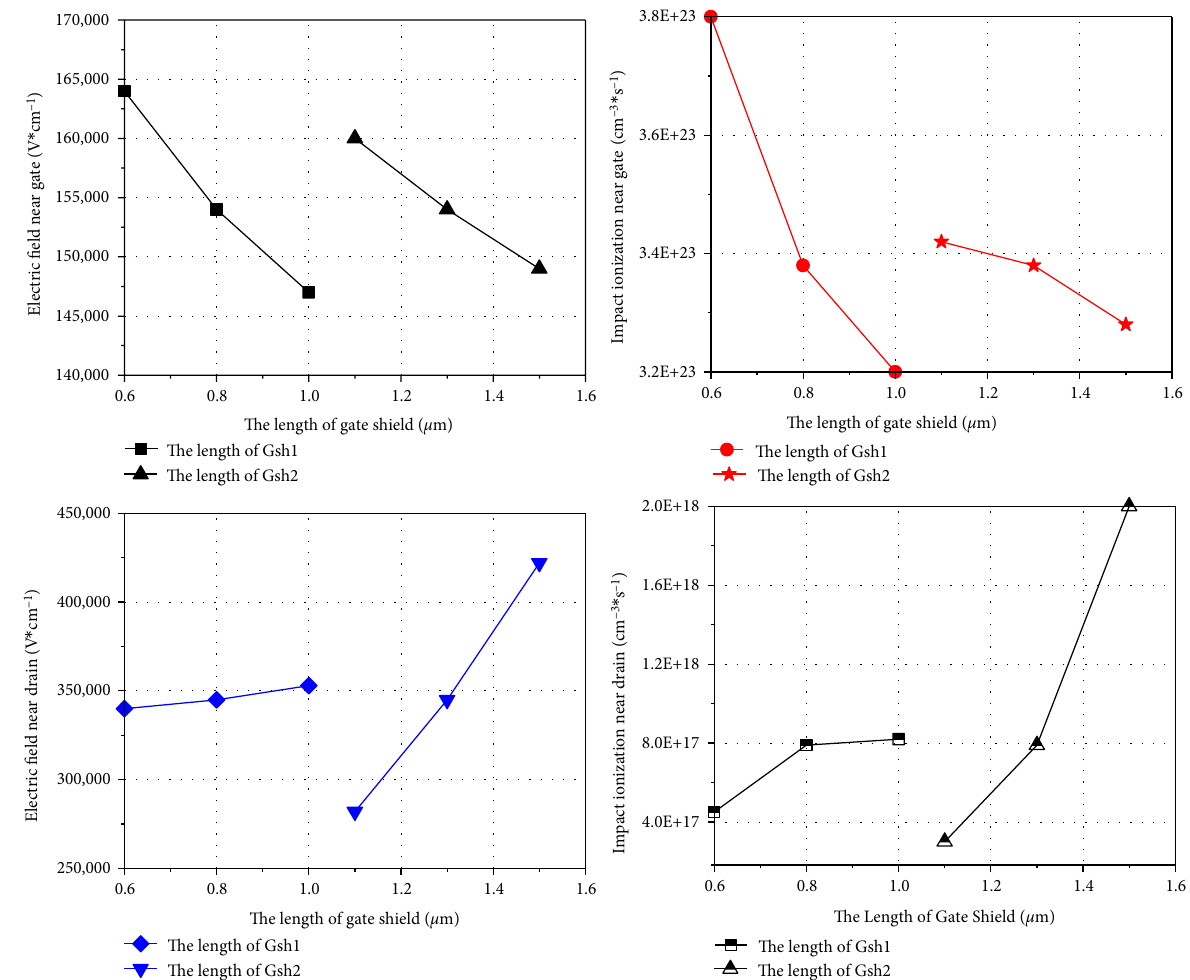
Figure 6: The relationship between peak electric field, impact ionization and the length of gate